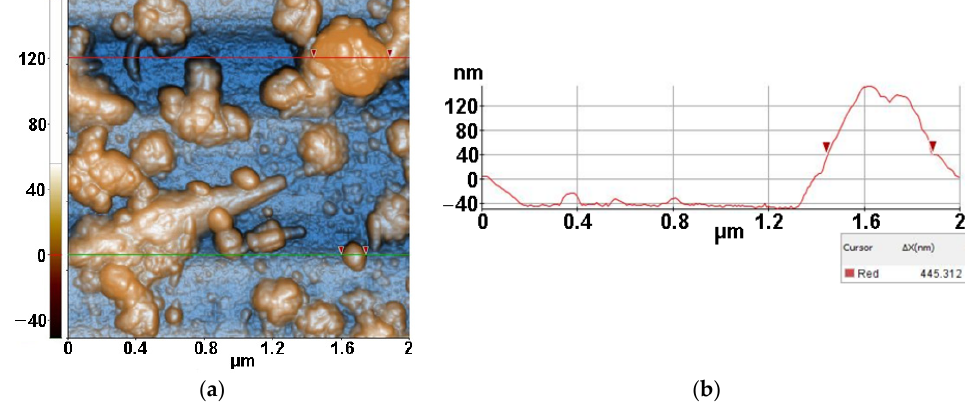
Figure 10. Two-dimensional AFM image of MC from inoculum with ZnSe after 30 min of irradia- tion deposited on glass substrate, recorded at the scale of 2 μ m × 2 μ m ( a ), together with a charac- teristic line scan ( b ).